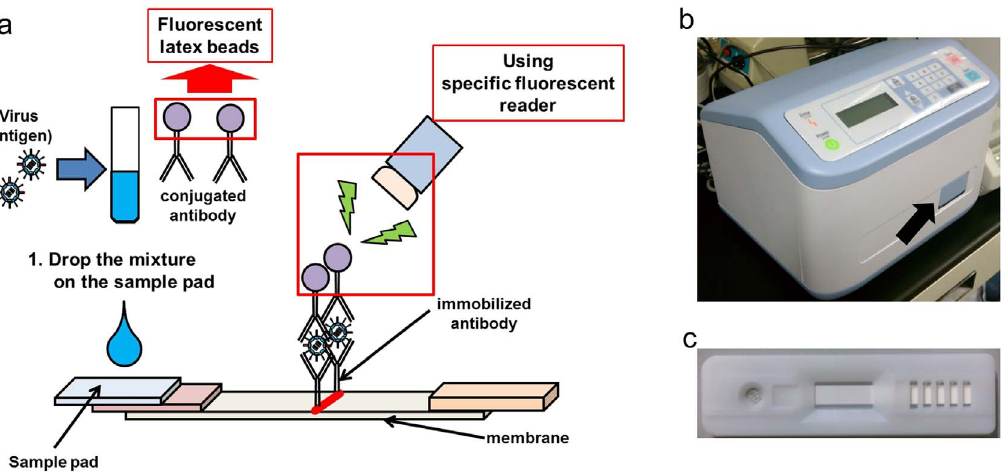
Figure 2. Principles and appearance of FLIC. (a) Fluorescent latex beads were conjugated to the detection antibody and the signal was detected by the specific fluorescent reader. (b) Photograph of the fluorescent reader. The arrow indicates the insertion slot for FLIC strip. (c) Photograph of the FLIC strip. doi:10.1371/journal.pone.0076753.g002 PLOS ONE |